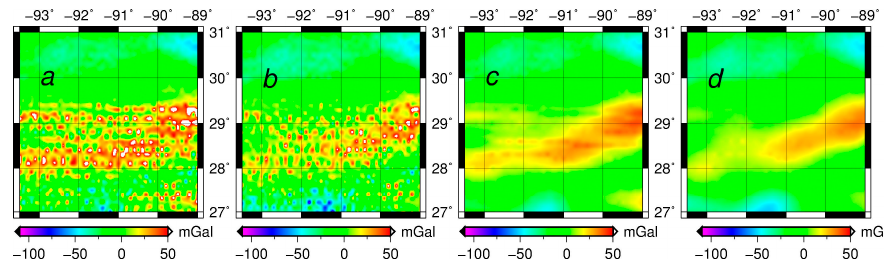
Figure 3. The distribution of the downward continued values in Louisiana Gravity Project ( a ) The inverse Poisson’s integral; ( b ) The semi-parametric method; ( c ) The regularization; ( d ) The semi- parametric method combined with regularization.